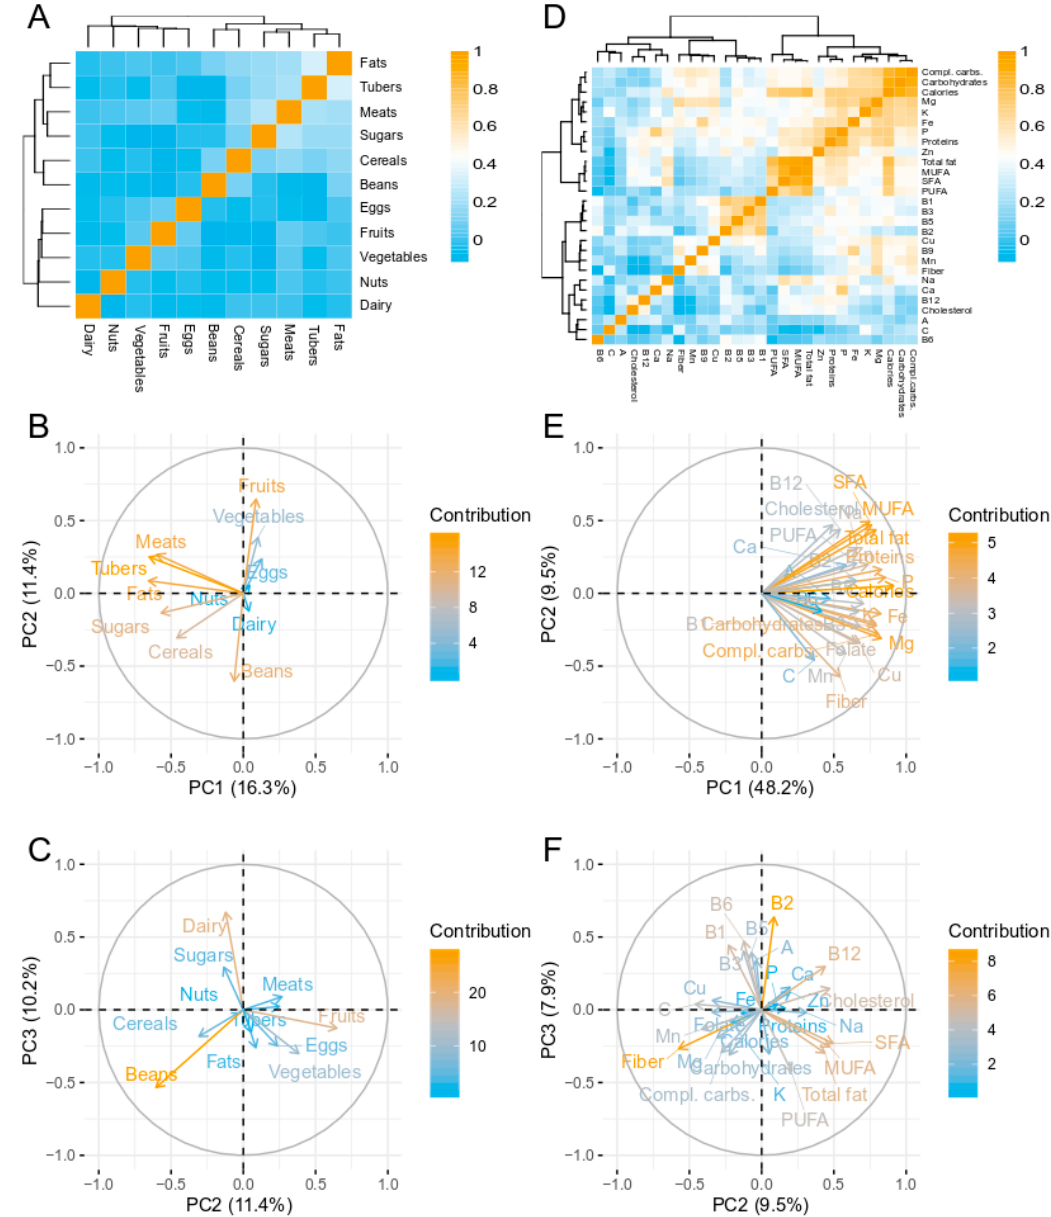
Figure 1. Diet features in the studied population. ( A ) Heatmap showing Pearson’s product moment correlations between pairs of food groups. Dendrograms obtained by hierarchical Ward-linkage clustering. ( B , C ) Principal component analysis (PCA) projecting the intake of food groups on the first three components. ( D ) Heatmap showing Pearson’s product moment correlations between pairs of nutrients. ( E , F ) PCA projecting the intake of nutrients on the first three components.